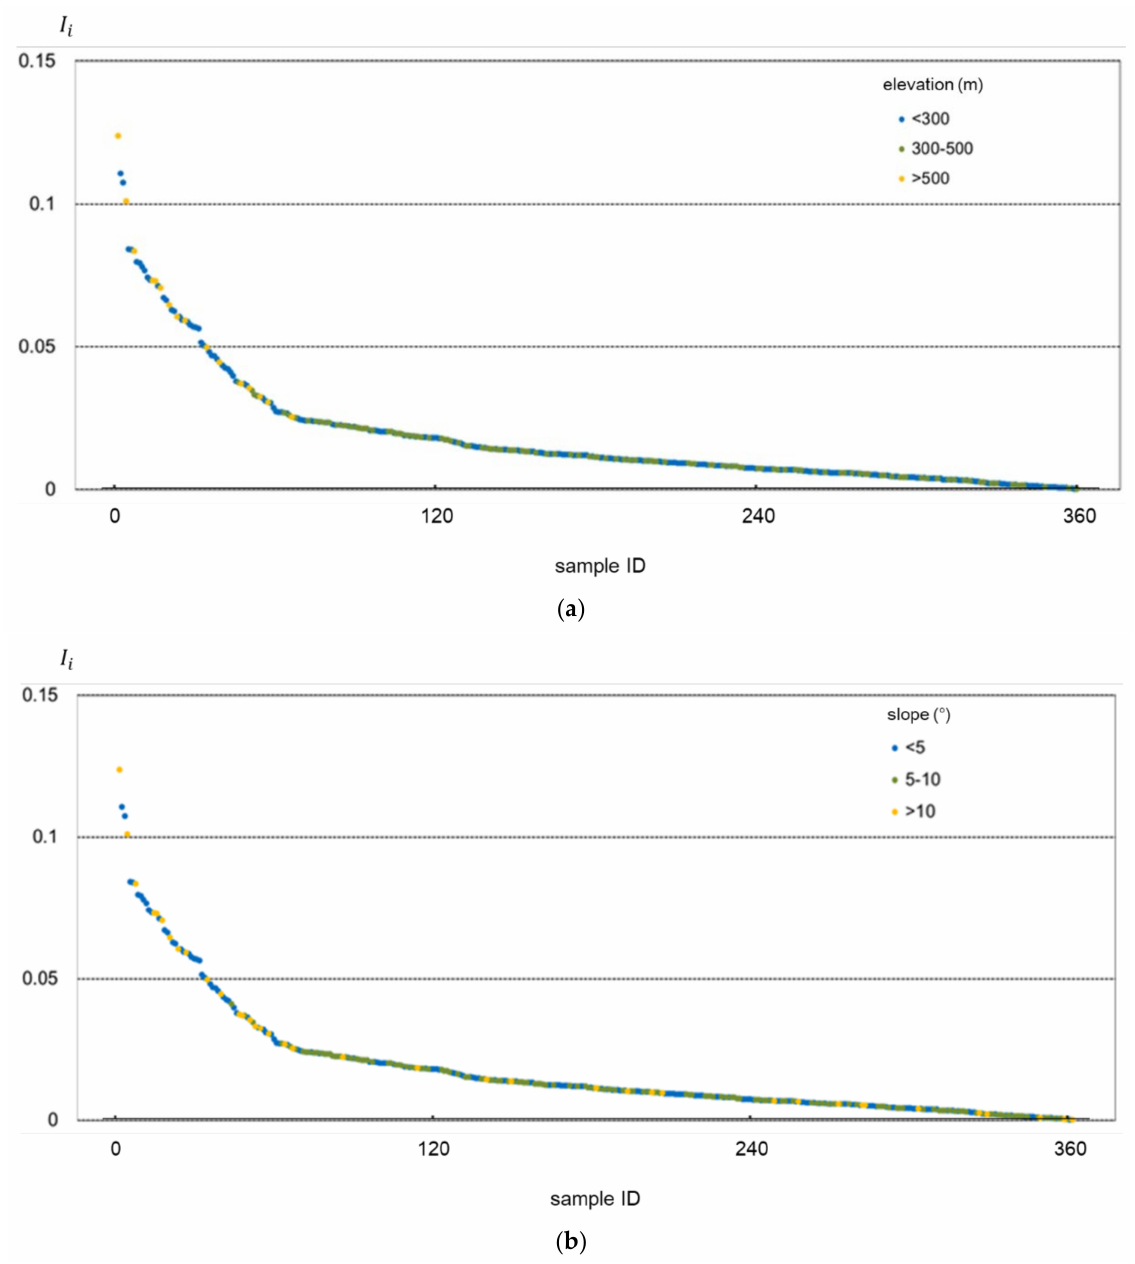
Figure 7. The accuracy improvement of samples by adding elevation as the input parameter. In ( a ), the samples are categorized into three groups by elevation and ( b ) by the